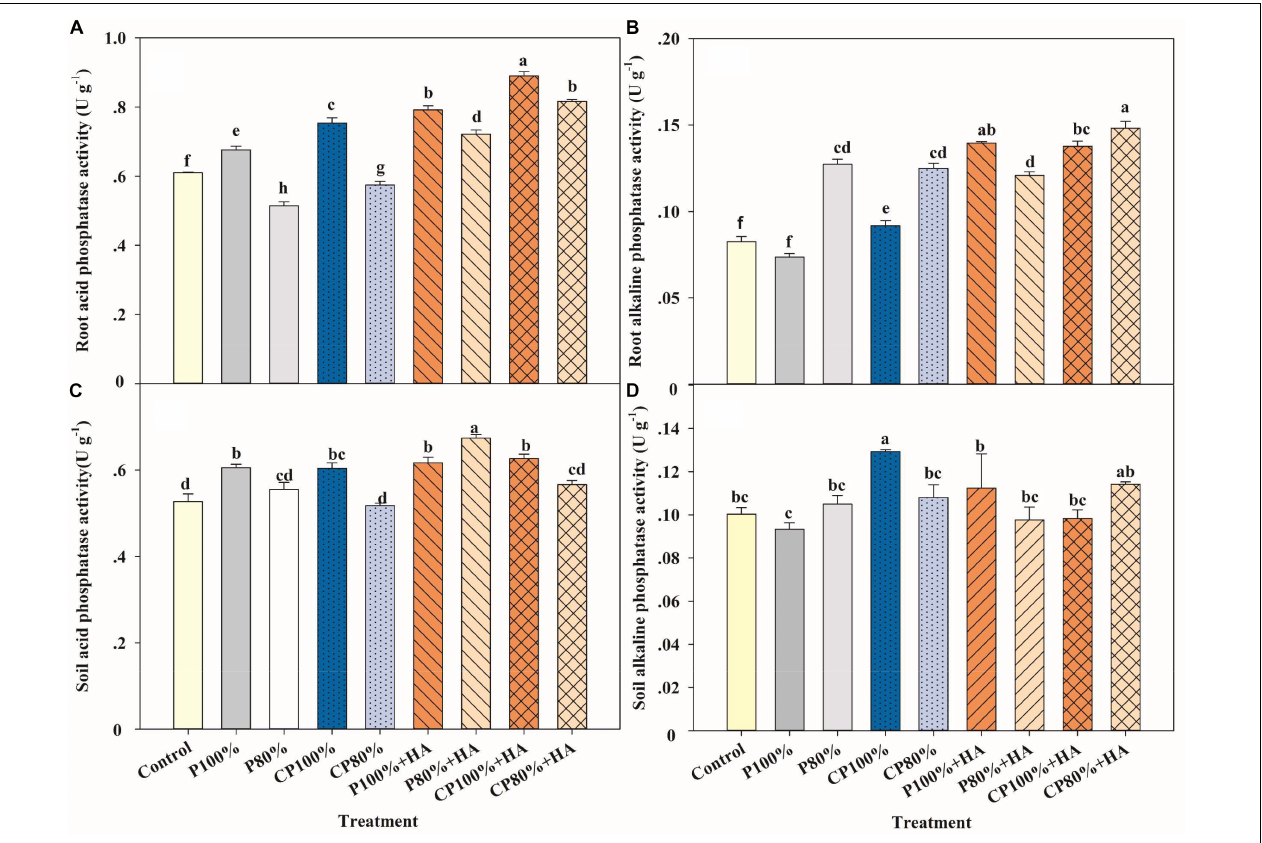
FIGURE 4 | Activities of root acid phosphatase (A) , root alkaline phosphatase (B) , soil acid phosphatase (C) , and soil alkaline phosphatase (D) in different fertilization treatments at the twelve-leaf stage of maize. Control, no P fertilizer added; P 100%, diammonium phosphate (DAP) at 75 kg P 2 O 5 ha − 1 ; P80%, DAP at 60 kg P 2 O 5 ha − 1 ; CP 100%, coated DAP (CDAP) at 75 kg P 2 O 5 ha − 1 ; CP 80%, CDAP at 60 kg P 2 O 5 ha − 1 ; P 100% + HA, DAP at 75 kg P 2 O 5 ha − 1 and combined with humic acid (HA); P 80% + HA, DAP at 60 kg P 2 O 5 ha − 1 and combined with HA; CP 100% + HA, CDAP at 75 kg P 2 O 5 ha − 1 and combined with HA; CP 80% +HA, CDAP at 60 kg P 2 O 5 ha − 1 and combined with HA. Different letters above the bars indicate significant differences at P < 0.05 followed by Duncan’s multiple range